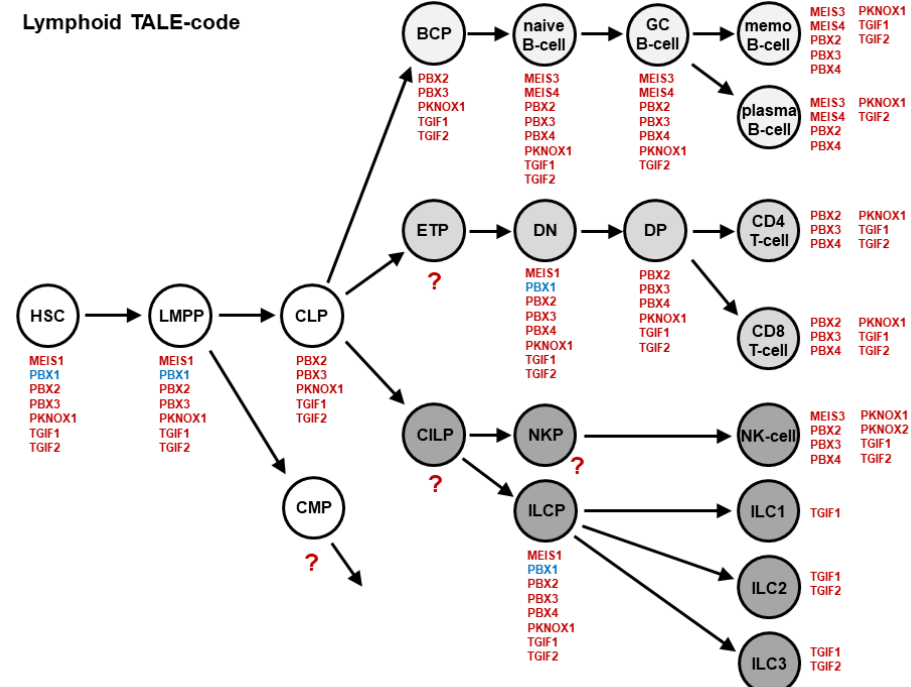
Figure 2. The lymphoid TALE-code describes the activities for TALE homeobox genes (red) in stages and cell types of early hematopoiesis and lymphopoiesis, including developing B-cells, T-cells, NK- cells, and ILCs. TALE homeobox gene PBX1 is highlighted in blue. BCP: B-cell progenitor; CILP: Common innate lymphoid cell progenitor; CLP: Common lymphoid progenitor; CMP: Common myeloid progenitor; DN: Double negative thymocytes; DP: Double positive thymocytes; ETP: Early T-cell progenitor; GC: Germinal center; HSC: Hematopoietic stem cell; ILC: Innate lymphoid cells; LMPP: Lymphoid and myeloid primed progenitor; memo: Memory; NKP: NK-cell progenitor; ?: Cell types with unknown TALE gene activities.